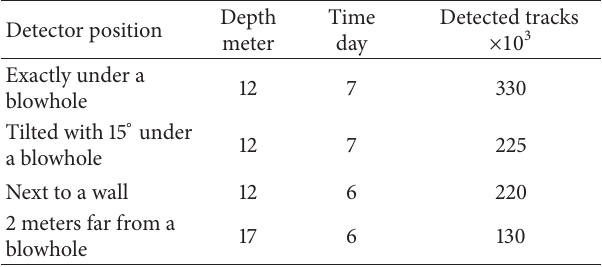
Table 1: The summary of the test measurements with the detector positions, depths, measurement times, and detected